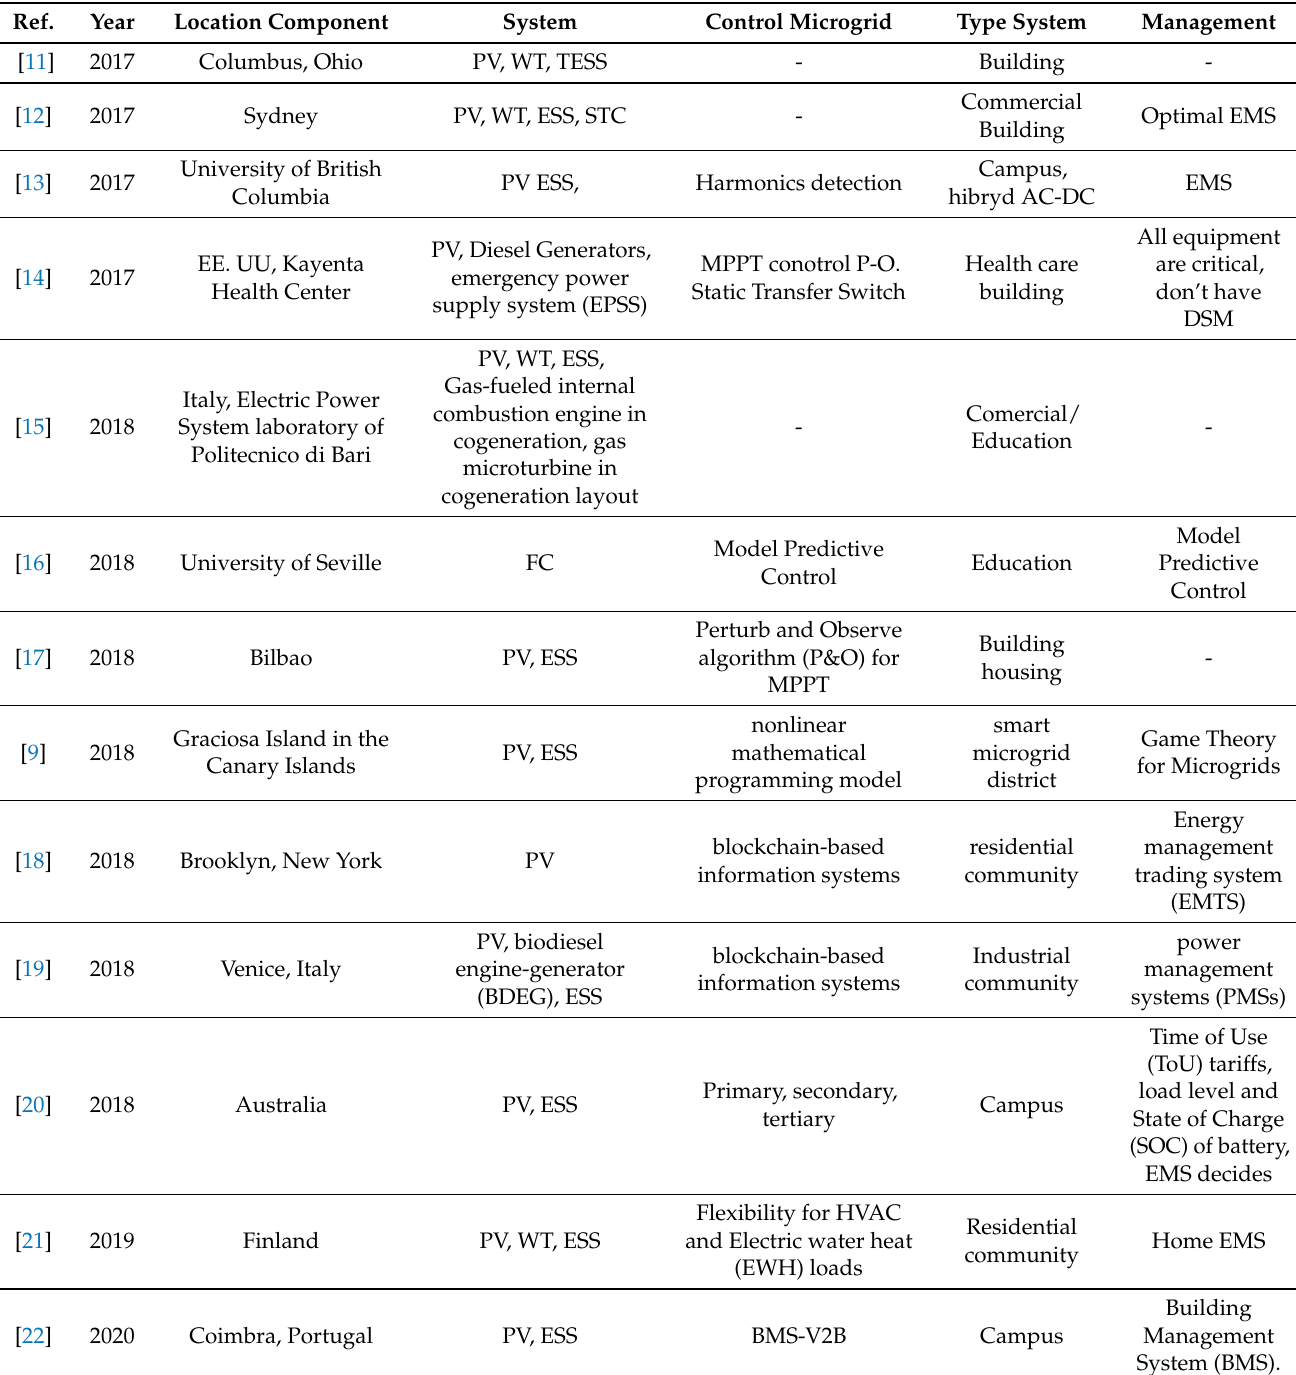
Table 1. Microgrid case studies; LV distribution networks.